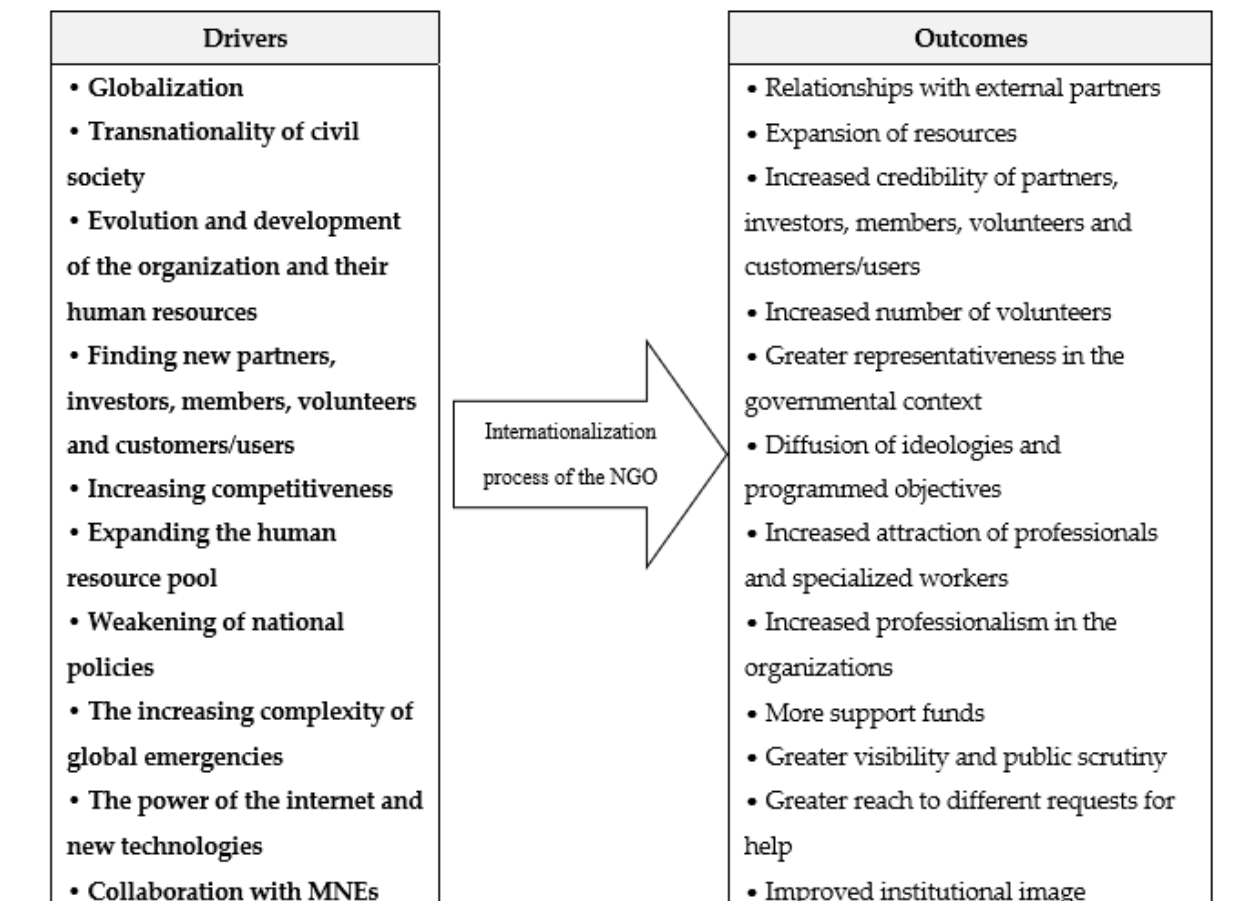
Figure 2. Synthesis of the main drivers and outcomes of the internationalization process of NGOs.